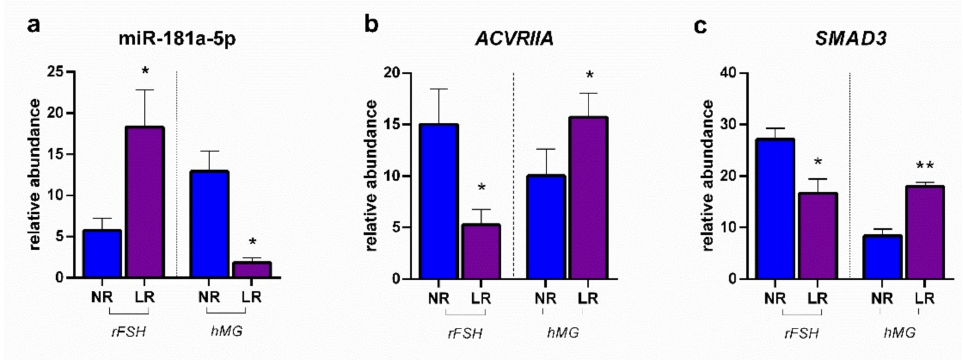
Figure 2. Expression profiles: ( a ) miR-181a-5p; ( b ) ACVRIIA : activin A receptor type 2A; ( c ) SMAD3 : smad family member 3. Results are reported as mean ± standard deviation. Statistical significance was set at p < 0.05 and calculated by Student’s t -test. Asterisks above columns indicate statistical differences between NR and LR groups. * = p < 0.05; ** = p < 0.01.